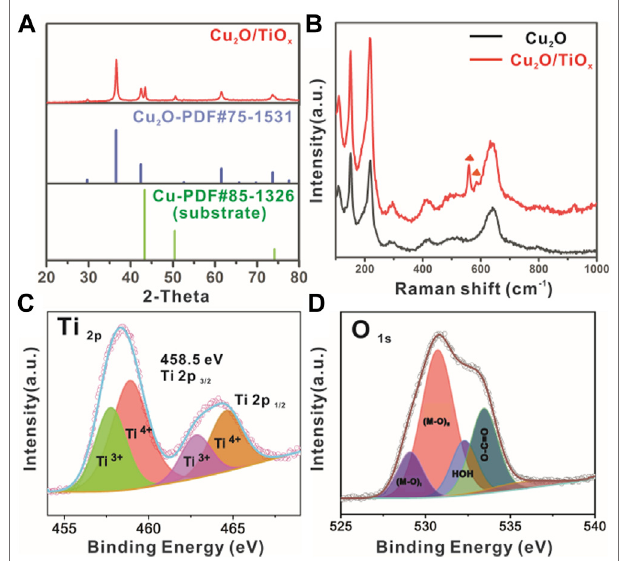
FIGURE 3 | (A) XRD pattern of typical Cu 2 O/TiO x NWA sample; (B) Raman spectra of Cu 2 O and Cu 2 O/TiO x NWA samples; (C,D) X-ray photoelectron spectroscopy signal of Ti 2p and O 1s from Cu 2 O/TiO x ,